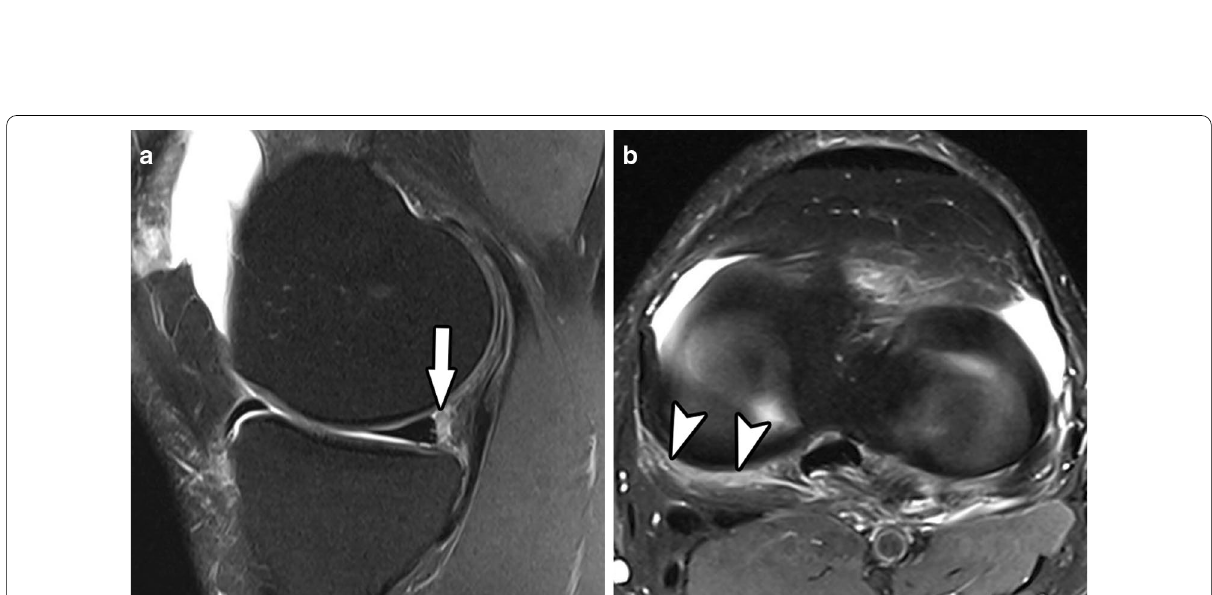
Fig. 13 Type 4B meniscal ramp lesion MRI case. Sagittal ( a ) T2‑weighted fat‑suppressed MR image shows a type IV ramp lesion, with a complete meniscocapsular disruption of the posterior horn of medial meniscus. Axial ( b ) image shows a cross‑sectional view of the extensive meniscocapsular disruption